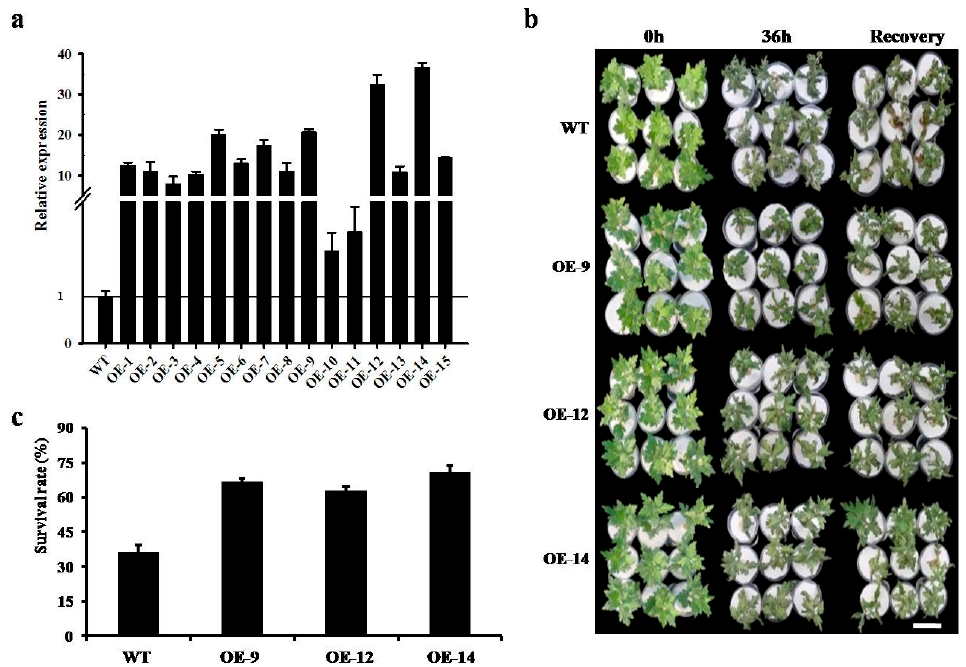
Figure 4. The relative expression level of CmWRKY10 gene in the overexpressed lines. Results are shown as means ± standard deviation (bars) of three biological repeats; ( a ) phenotypic comparison of CmWRKY10 overexpressed lines(OE-9, OE-12 and OE-14) and wild-type ‘Jinba’ before and after the drought-stress treatment Scale bars = 60 mm ( b ). The survival rate of the wild-type plants and the overexpressed lines (OE-9, OE-12 and OE-14) after 5 days from a sample size of 65 plants of each individual genotype. Bars represent the standard deviation among three independent replicates ( c ).